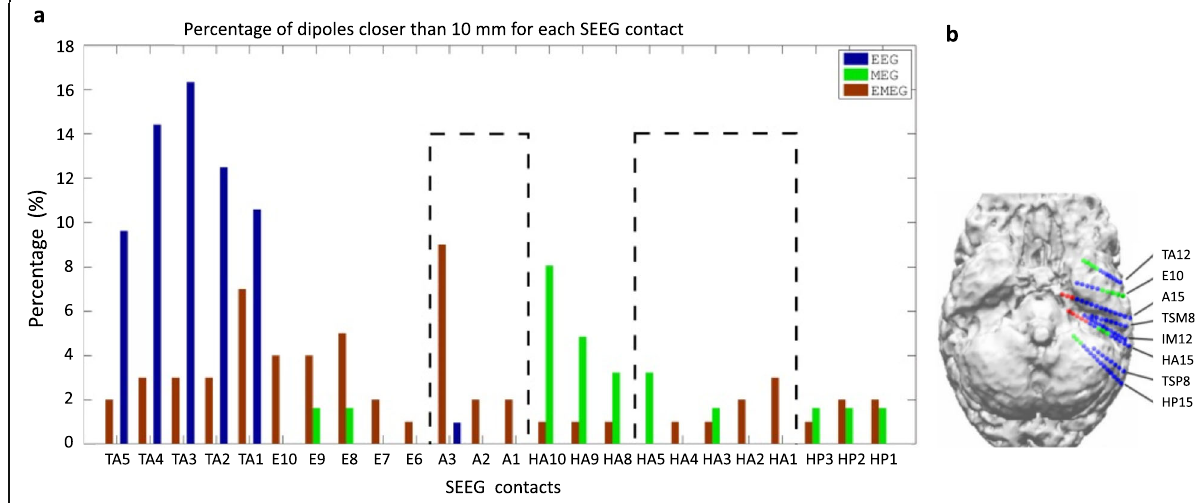
Fig. 1 Comparison of EEG, MEG and combined EEG/MEG (EMEG) localization with epileptic activity detected in invasive EEG. a Quantitative comparison of MEG/EEG source localization stereoelectroencephalography (SEEG) contacts. Square distance index and the percentage of dipoles closer than 10 mm for each SEEG contact. Values are given for EEG and MEG/EEG subaverages of 10 spikes. The point of time for source localization was at − 23 ms before spike peak. Dashed lines enclose SEEG contacts within the seizure onset zone [17]. The simultaneous MEG/EEG source localization was mostly (compared to EEG or MEG) congruent with the invasive SEEG-delineated seizure onset electrodes. b The position of SEEG depth electrodes in the investigated